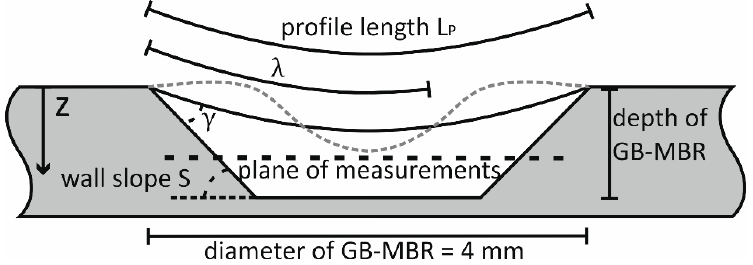
Figure 3. Schematic of GB-MBR cross-section. The diameter of the reactor is 4 mm , the nominal depth is 1 mm but was measured to be 0.9 mm only. Also shown are the contact angle 𝛾 , wall slope 𝑆 , wavelength 𝜆 , profile length 𝐿 (cid:3017) , the plane where most PIV were done, and the direction of the z